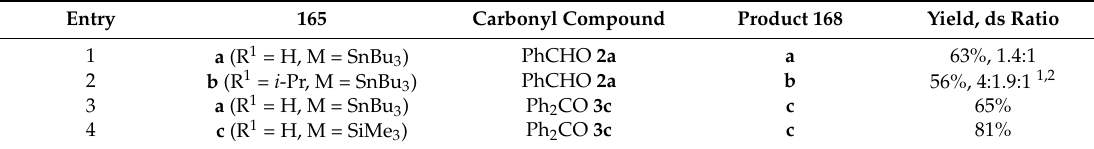
Table 22. Cycloaddition of azomethine ylides 167 to aldehyde 2 a and ketone 3c (Scheme 40).